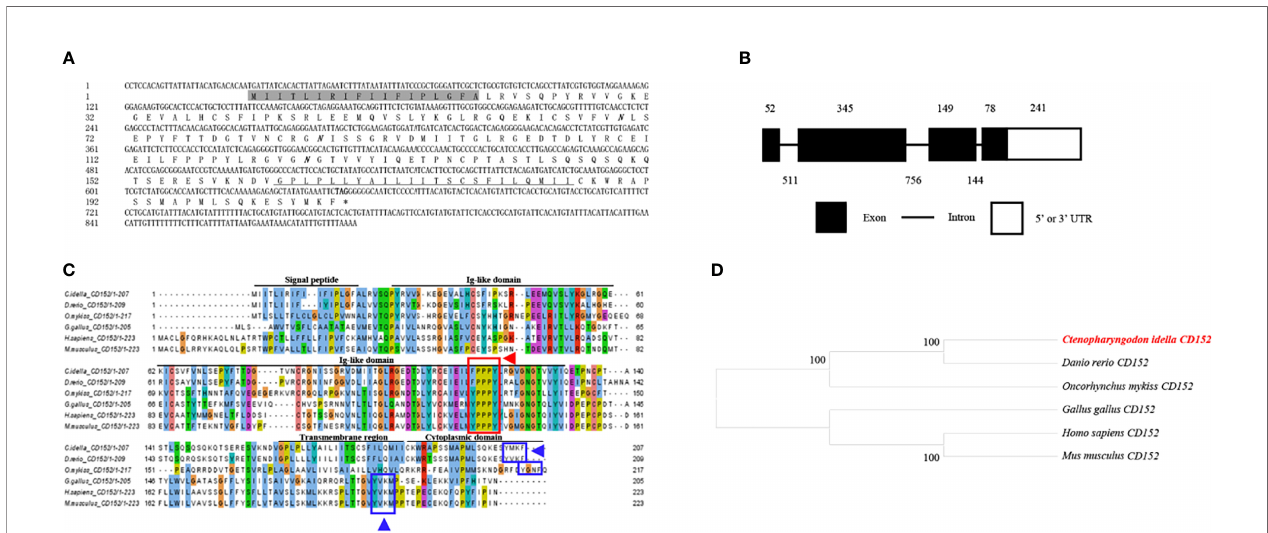
FIGURE 3 | Molecular cloning and bioinformatic analysis of the CD152 gene in grass carp. (A) The cDNA and deduced amino acid sequences of CD152. The signal peptide is shadowed, and the transmembrane domain is underlined. The asterisk indicates the stop codon. The locations of the predicted NGSs are shown in bold and italic. (B) The exon/intron structure of the CD152 gene in grass carp. The rectangles represent the exons, and the lines between them indicate the introns. The black and white areas indicate the coding regions and the 5 ’ or 3 ’ UTRs, respectively. The size (bp) of the exons and introns are shown by the numbers above and below, respectively. (C) Multiple amino acid sequence alignment of the CD152 homologs. The sequence alignment was conducted using the ClustalX program. The predicted domains of grass carp CD152 were marked above the amino acid sequence. The conserved binding motifs for the CD80/86 binding are highlighted by the red rectangle. The tyrosine-based motifs in the cytoplasmic domain were indicated by blue rectangles. (D) Phylogenetic analysis of the CD152 homologs. Protein sequences were used to construct the phylogenetic tree using the neighbor-joining method bootstrapped 1000 times with the MEGA program. The grass carp CD152 is shown in red. The GenBank accession numbers for the used sequences are shown below: H. sapiens , NP_005205.2; M. musculus , NP_033973.2; G. gallus , CAJ86460.1; D. rerio , XP_005167576.1; C. Idella , UGY70977.1; O. mykiss , AAW78854.1.